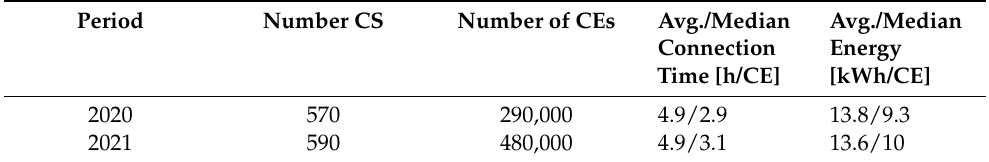
Table 5. KPIs of AC Charging Events from the Real-World Data Set.